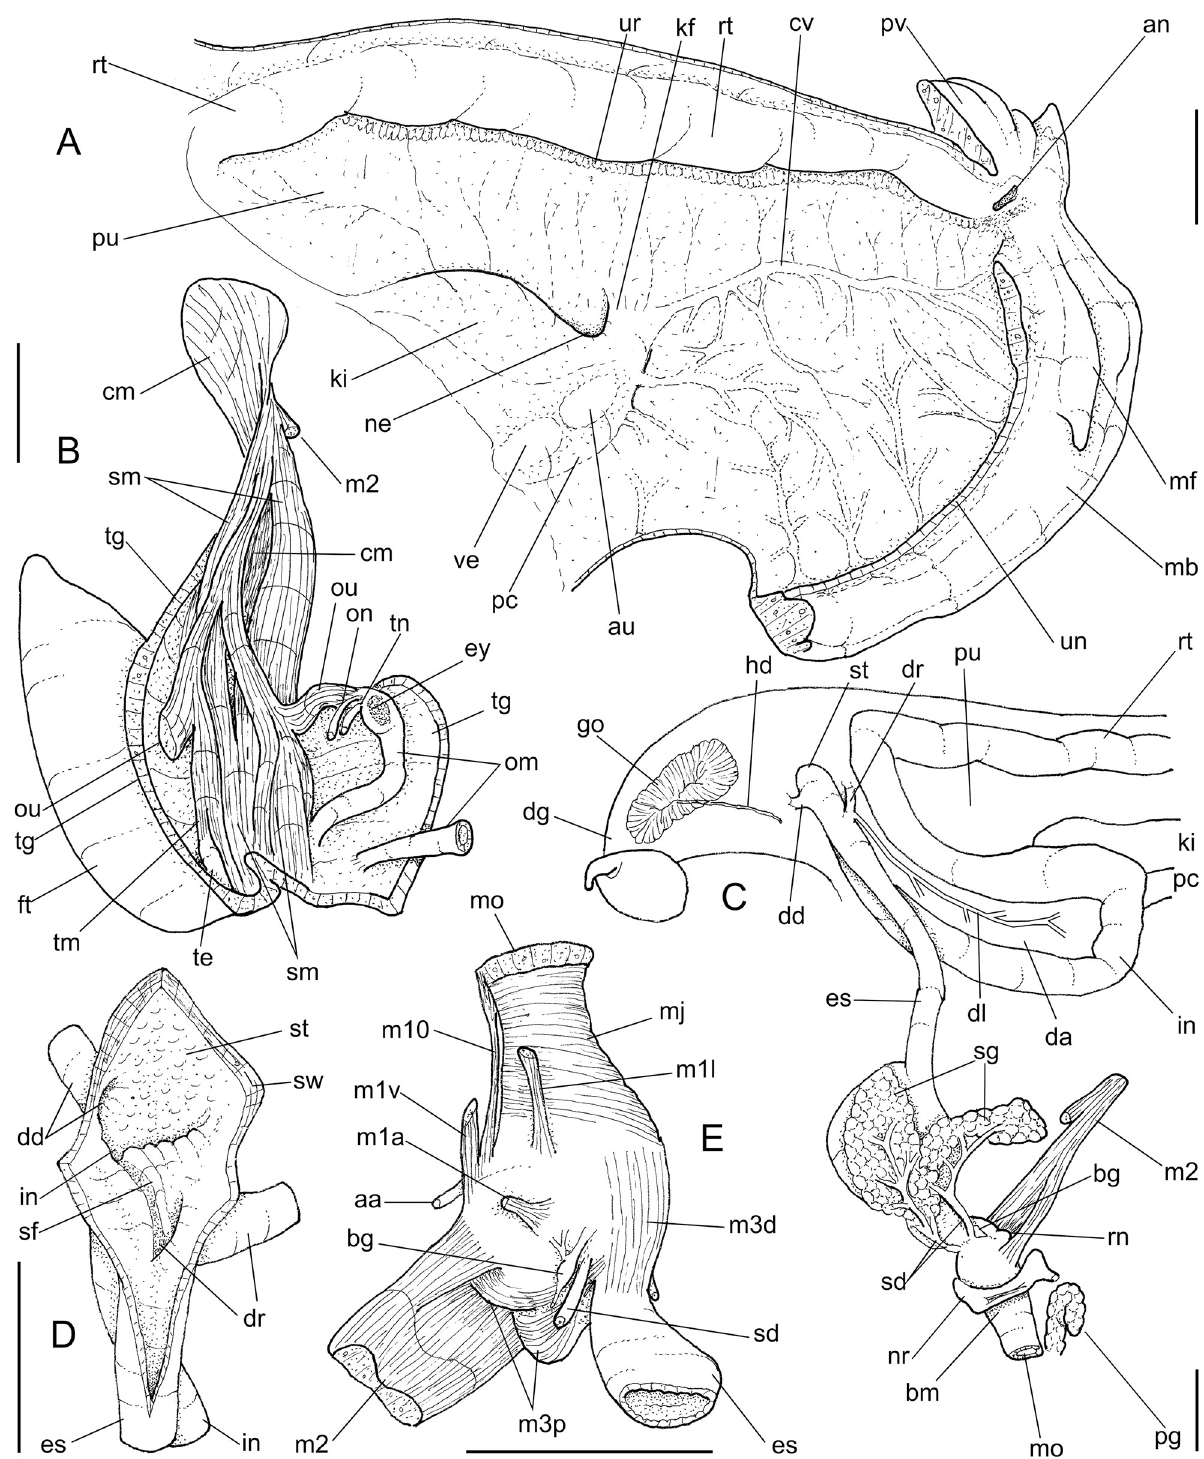
Fig 21. Catracca uhlei , anatomy. (A) Pallial cavity roof, ventral view, pneumostome ventral lip sectioned and deflected upwards. (B) Head-foot, head, digestive and genital structures removed, anterior integument sectioned and deflected to left (right in Fig), main concern to main head-foot musculature. (C) Fore- and midgut, mostly ventral view, shown as in situ, topology of some adjacent structures also shown. (D) Stomach, ventral view, mostly sectioned longitudinally to show inner surface. (E) Buccal mass, left view. Scales = 5 mm.